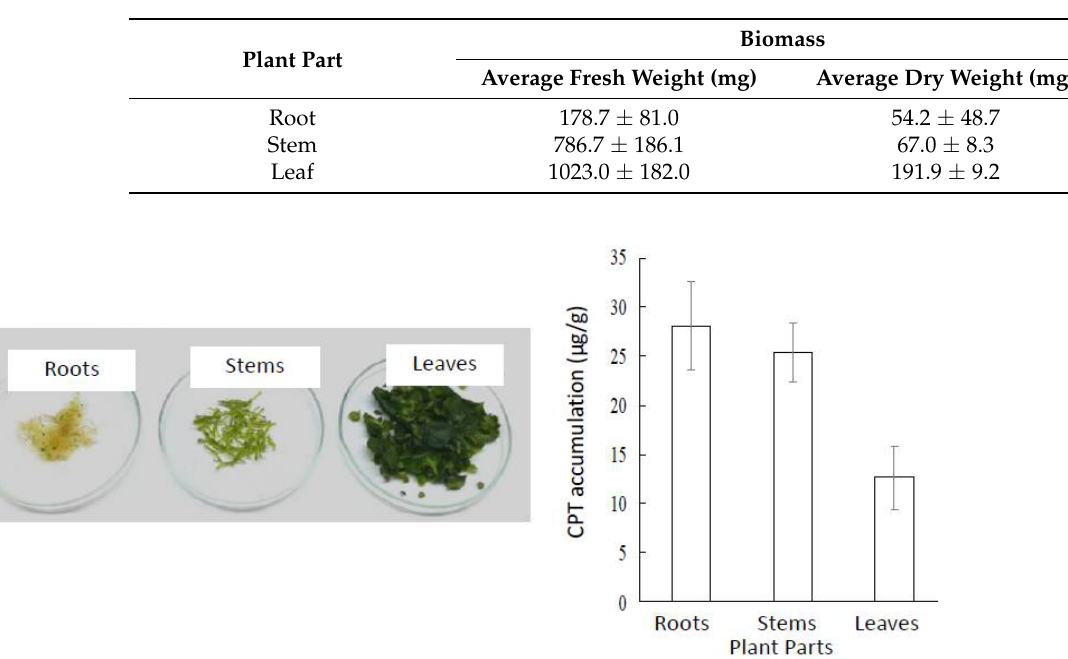
Table 1. Biomass of fresh and dry weights in different parts of 5-month-old tissue culture plants of